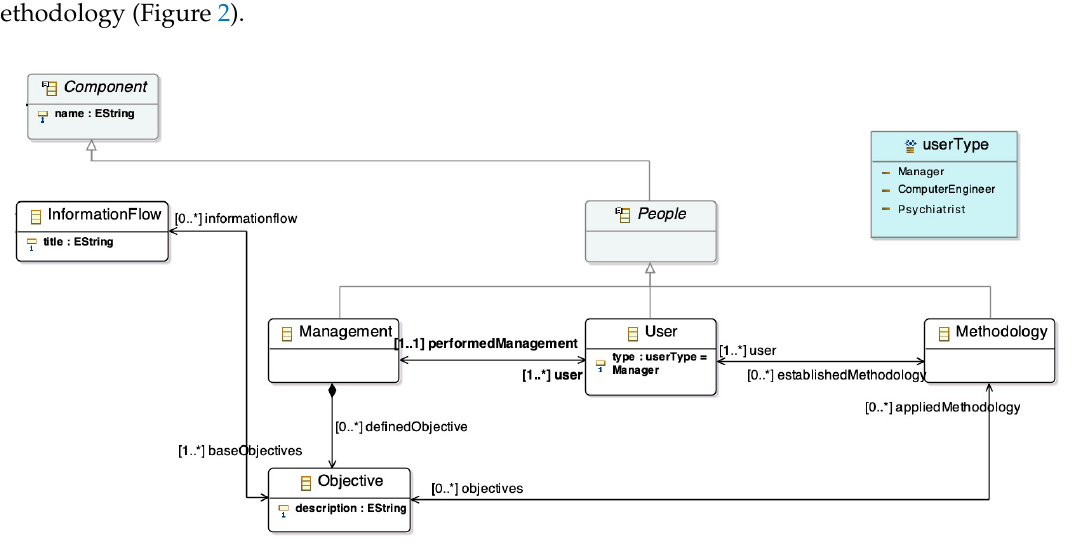
Figure 2. Human factor in the learning ecosystem meta-model. Based on [36] .